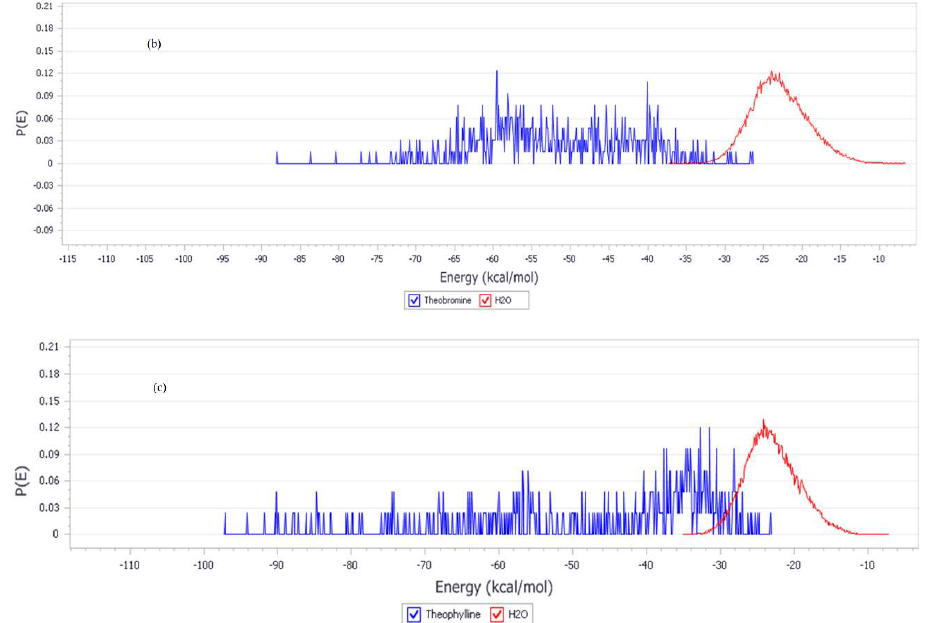
Figure 4. Adsorption energy distributions for ( a ) Cu(111)/Caffeine/100H 2 O, ( b ) Cu(111)/ Theobromine / 100H 2 O, and ( c ) Cu(111)/ Theophylline /100H 2 O systems. Coatings 2020 , 10 , x FOR PEER REVIEW Table 7. Adsorption Energy for the most stable configurations for Cu(111)/Caffeine/100H 2 O,Cu(111)/Theophylline/100H 2 O and Cu(111)/Theobromine/100H 2 O systems (all values are in kcal/mol).